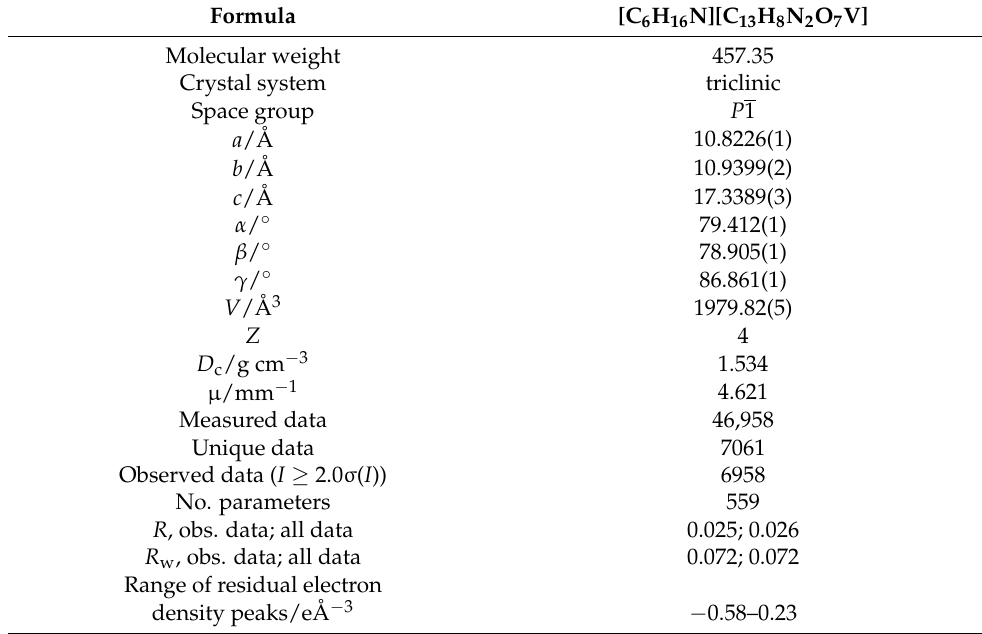
Table 5. Crystallographic data and refinement details for salt 1